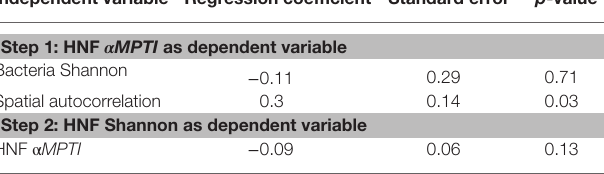
Independent variable Regression coefficient Standard